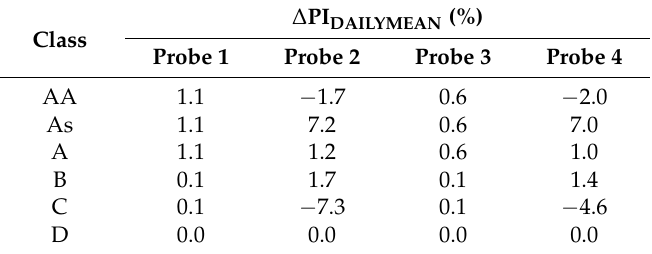
Table 11. Differences between reference PI MINUTE values in Table 2 and PI obtained with the dataset associated to the daily means. Performance Index (PI) is calculated as the percentage of time for which the combination of T and RH data fits into the specifications of each ASHRAE climate class. The differences ∆ PI DAILYMEAN are calculated as (PI DAILYMEAN – PI MINUTE ). ∆ PI DAILYMEAN (%) Class Probe 1 Probe 2 Probe